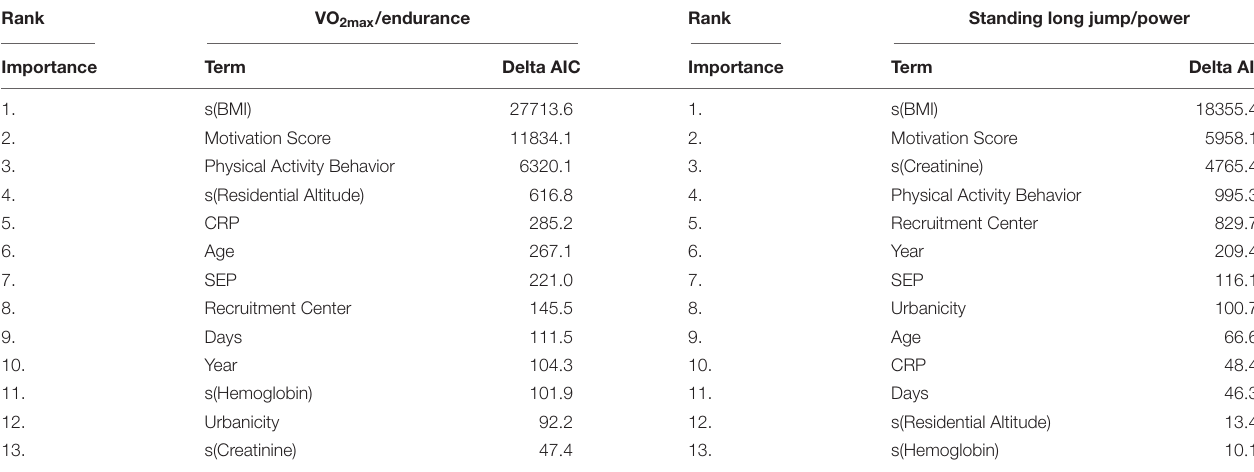
TABLE 2 | Rating of explanatory factors from the adjusted endurance (VO 2max ) and muscle power performance (Standing Long Jump) GAM models sorted according to contribution to AIC (Akaike’s information criterion), based on the full dataset after multiple imputation. Rank VO 2max /endurance Rank Standing long